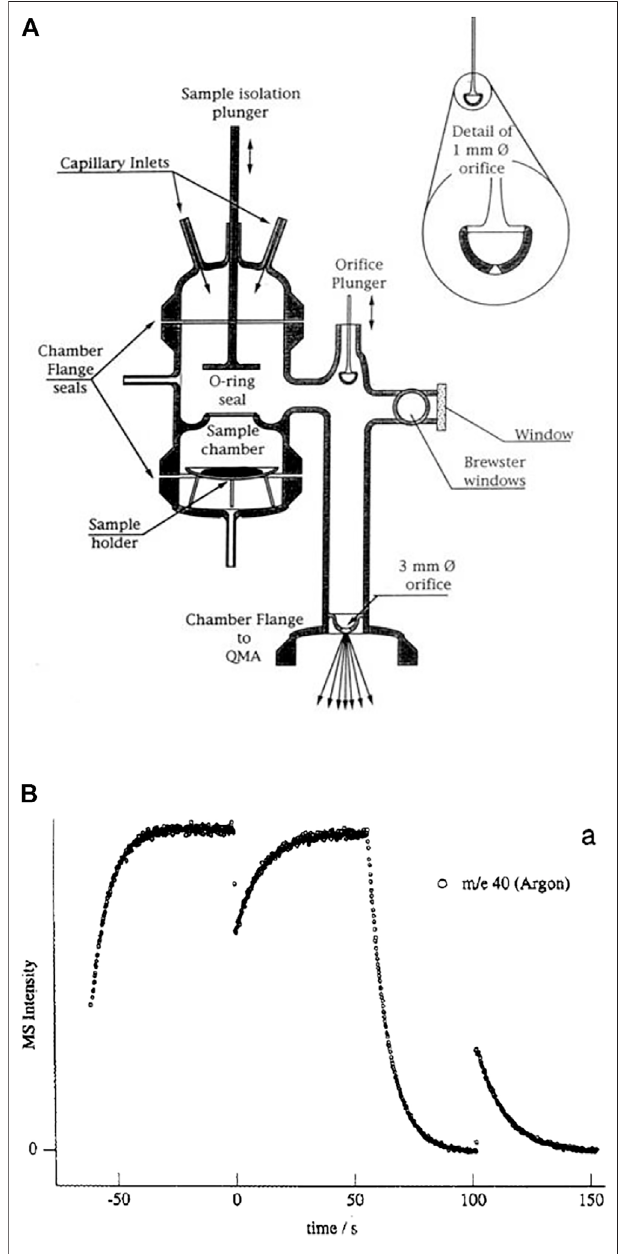
FIGURE 3 | (A) All-Pyrex Knudsen fl ow reactor whose characteristic data are displayed in Table 1 . The nominal 1 mm diameter ori fi ce fi ts into the hemispherical glass counterseal (Rotulex ground glass joint) ofthe base of the fl ow reactor whose aperture diameter is 3 mm wide. The hemispherical insert with the 1 mm ori fi ce hole is attached to the transfer rod (plunger) that lowers or raises the part using three thin glass rods fused to the transfer rod (Tabor et al., 1994). (B) . Transient pressure of Ar at a fl ow rate of 8.0 × 10 15 molecules s − 1 in the 1 mm diameter all-Pyrex ori fi ce reactor displayed in Figure 3A (Tabor et al.,